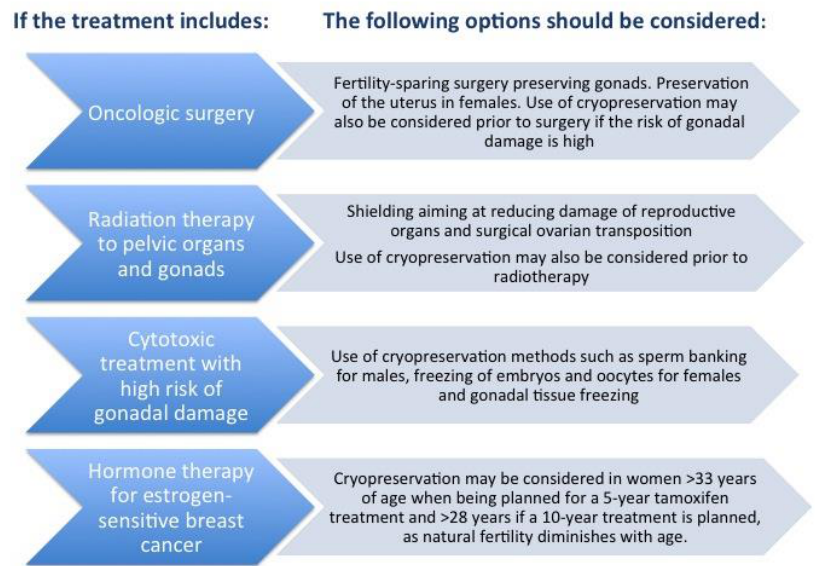
Figure 1. Fertility preservation strategies depending on the type of oncological treatment in females and males. Reprinted with permission from Rodriguez-Wallberg and Oktay. Cancer Management and Research 2014, 6, 105–117; originally published by and used with permission from Dove Medical Press Limited.